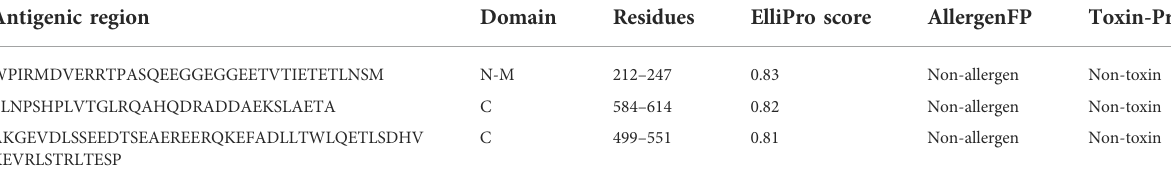
TABLE 3 Structure based predicted B-cell epitopes, according to ElliPro (score threshold